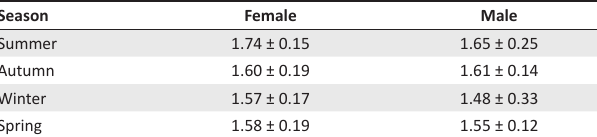
TABLE 5: Mean condition factor per season of parasitised female and male Hydrocynus vittatus per season in the Sanyati Basin, Lake Kariba. Season